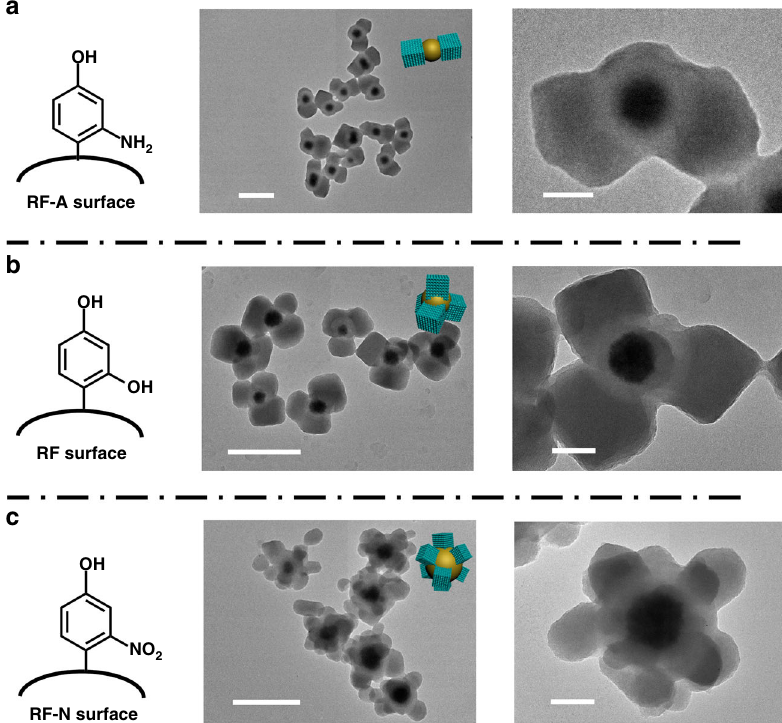
Fig. 3 The growth of PMO cubes on nanoparticles with different functional groups. a – c The structure of the surface functional groups on Fe 3 O 4 @SiO 2 @RF- A, Fe 3 O 4 @SiO 2 @RF, and Fe 3 O 4 @SiO 2 @RF-N nanoparticles and the corresponding TEM images with different magni fi cations of the obtained multipods nanocomposites: a The growth of PMO cubes on core@shell Fe 3 O 4 @SiO 2 @RF-A nanoparticles with phenolic amino surface functional groups and TEM images with different magni fi cations of the obtained dual-pods Fe 3 O 4 @SiO 2 @RF-A&PMOs nanocomposites; b The growth of PMO cubes on the core@shell Fe 3 O 4 @SiO 2 @RF nanoparticles with phenolic hydroxyl surface functional groups and the TEM images with different magni fi cations of the obtained tetra-pods Fe 3 O 4 @SiO 2 @RF&PMOs nanocomposites; c The growth of PMO cubes on the surface of Fe 3 O 4 @SiO 2 @RF-N nanoparticles with phenolic nitro functional groups and TEM images with different magni fi cations of the obtained multipods Fe 3 O 4 @SiO 2 @RF-A&PMOs nanocomposites. Insets are the 3D structural model of the respective nanocomposites. Scale bars represent 500 nm for images in the middle line and 100 nm for images in the right